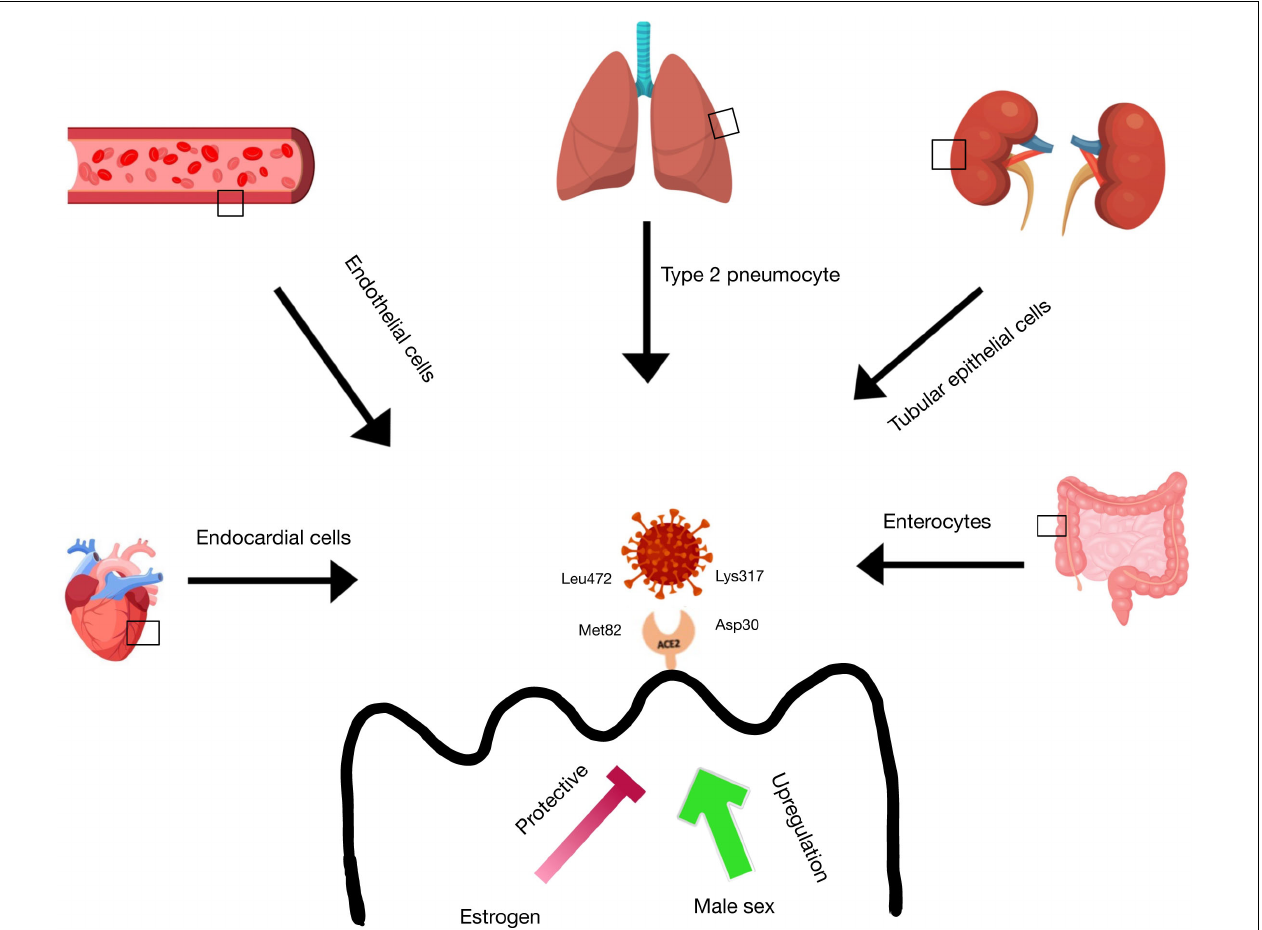
FIGURE 4 | ACE2 receptor expression in tissues. ACE-2 receptor expression is found in the lung type 2 pneumocytes, heart endocardial cells, blood vessel endothelial cells, kidney tubular epithelial cells, and intestinal enterocytes. There is evidence that estrogen has a protective function on ACE-2 receptor expression in these tissues, while male sex is correlated with an upregulation of ACE-2 receptors in these tissues. SARS-CoV-2 is able to bind to the ACE-2 receptor via ionic interactions between Lys317 on the virus and Asp30 on the receptor and via Van der Waals interactions between Leu472 on the virus and Met82 on the